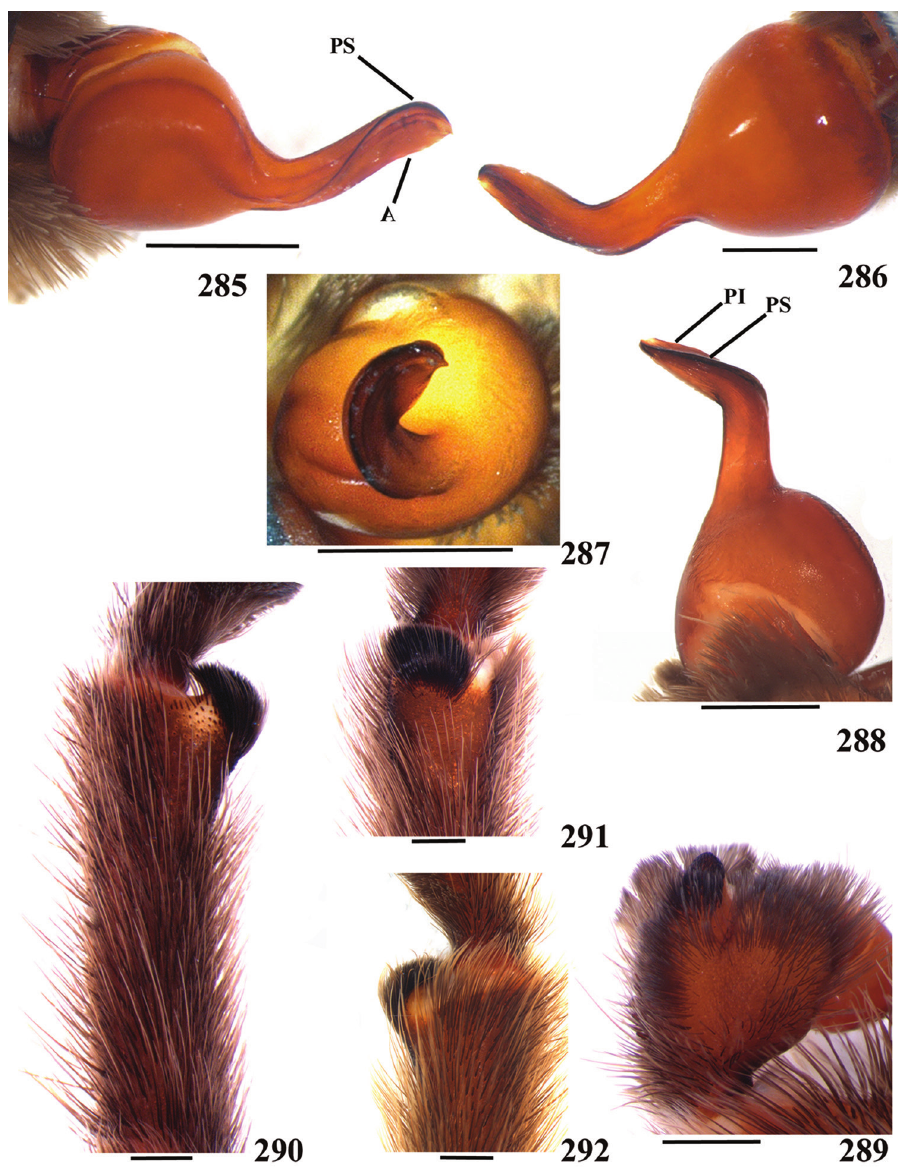
Figures 285–292. Antillena rickwesti (Bertani & Huff, 2013) comb. n., male (AMNH). 285–288 left palpal bulb 285 prolateral 286 retrolateral 287 frontal 288 dorsal 289 left cymbium, dorsal 290–292 left tibial apophysis of leg I 290 prolateral 291 ventral 292 retrolateral. Scale bars = 1 mm. Additional material. DOMINICAN REPUBLIC: Pedernales : 5 km south of Ma- nuel Goya [17°52'N, 71°29'W], 1 female, R. C. West col., 20 February 2012, in silk retreat of scrub tree (AMNH RW01); Jaragua National Park, Los Tres Charcos,